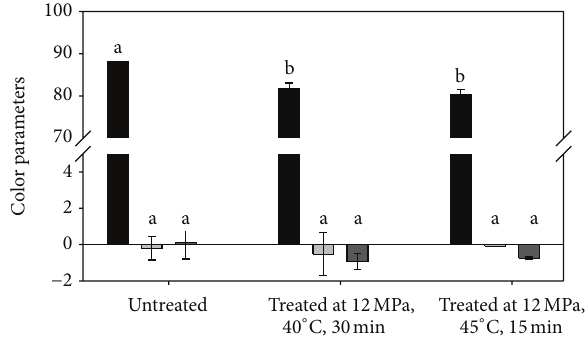
Figure 2: Color parameters of untreated and treated fresh-cut coconuts: lightness, 𝐿 ∗ ; light grey, 𝑎 ∗ ; dark grey, 𝑏 ∗ . Values with similar letters within bars are not significantly